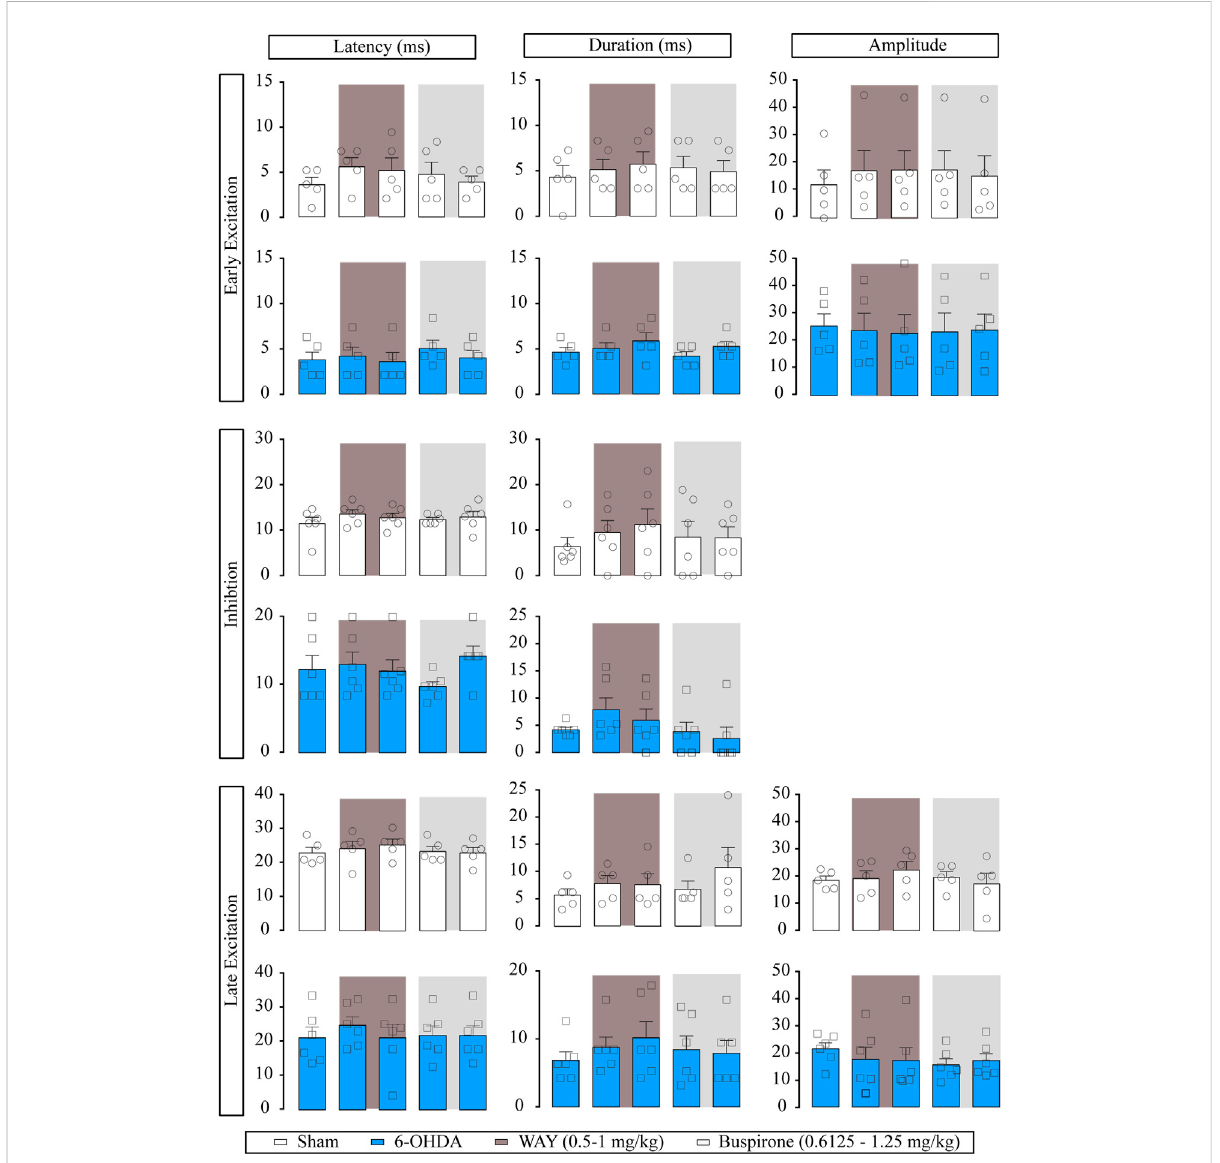
FIGURE 6 Effect of the systemic administration of WAY-100635 on motor cortico-entopeduncular information. Representation of characteristic parameters related to cortically evoked responses (latency, duration, and amplitude of the responses). The latency, duration, and amplitude of the earlyexcitatorycomponentareonthetop(sham n =5,6-OHDA n =5).Thelatencyanddurationoftheinhibitorycomponentareinthemiddle(sham n = 6, 6-OHDA n = 6). The latency, duration, and amplitude of the late excitatory component are on the bottom (sham n = 5, 6-OHDA n = 6). Eachbarrepresentsthemean±SEM.EachdotrepresentsthevaluefromoneneuronbeforeandafterWAY-100635(0.5 – 1 mg/kgi.v.)andbuspirone (0.6125 and 1.25 mg/kg, i.v.) in dark grey and in light grey,